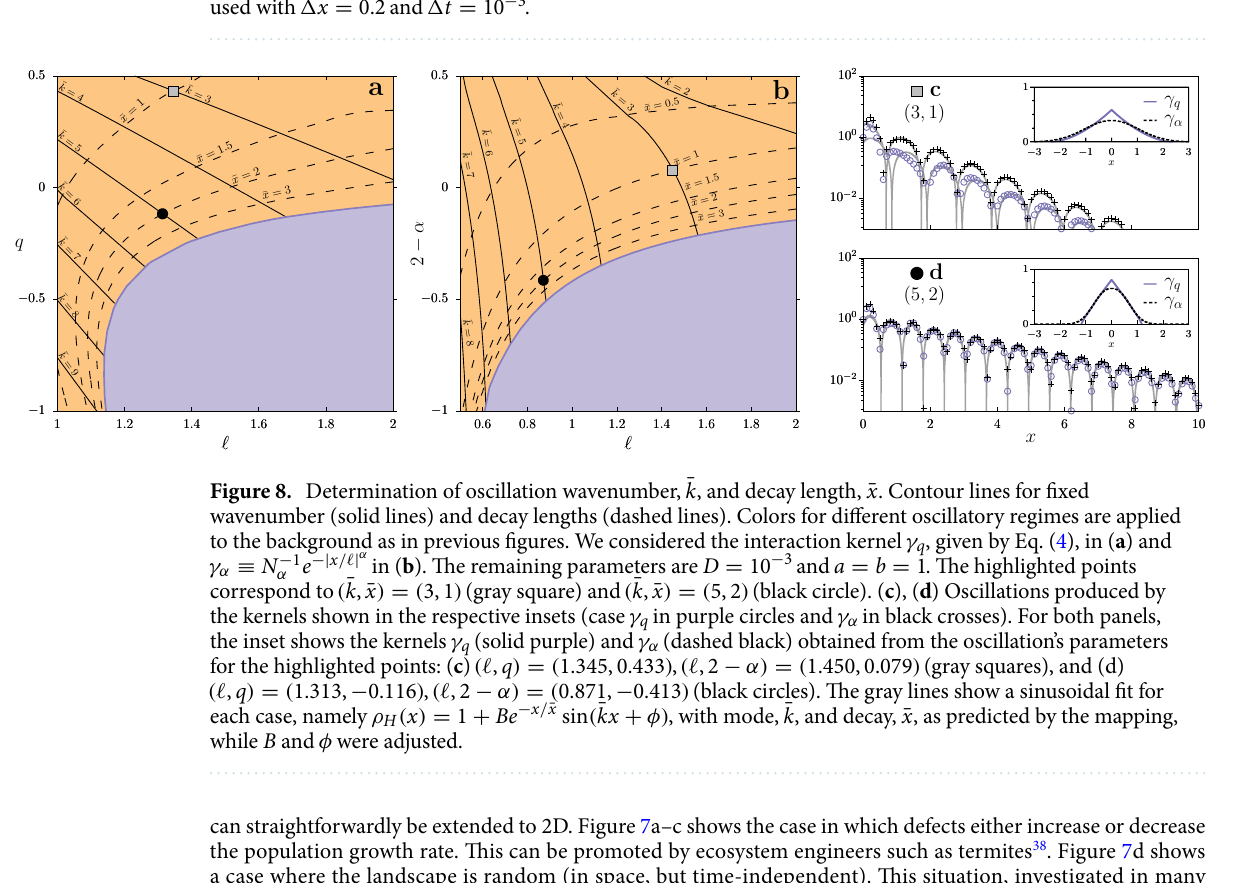
A (in − 2 and q 0.5 , = = ρ 0 (where −